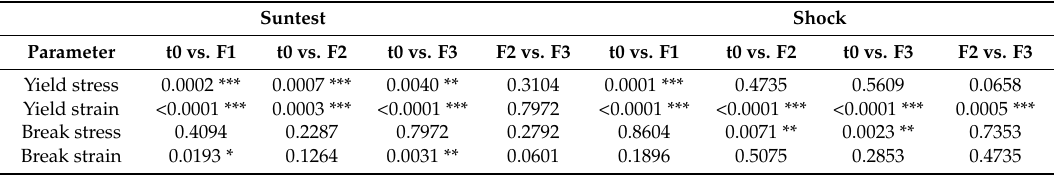
Figure 2. Trend of ( a ) yield strain; ( b ) yield stress; ( c ) break strain; and ( d ) break stress values obtained from all samples. Table 5. Statistical significance p values obtained from packaging analysis, summarized with one, two or three asterisks (*, **, ***) depending from the level of statistical significance.